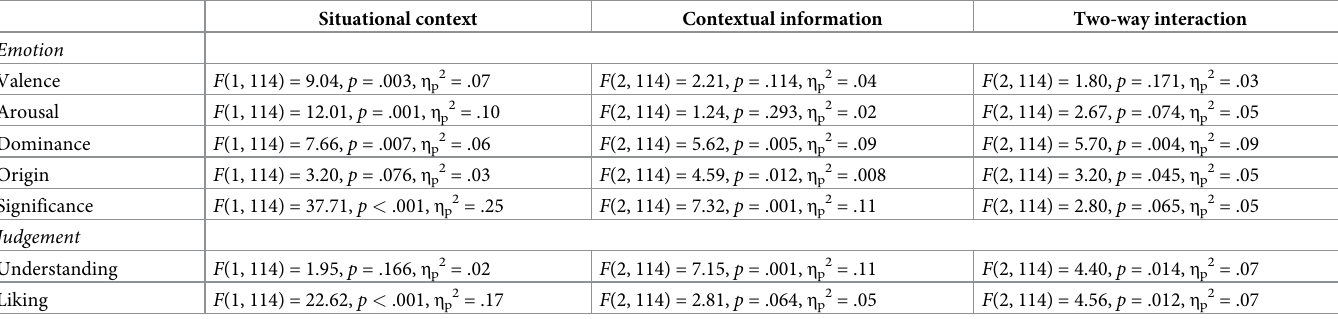
Table 2. Effects of situational context and the way of providing contextual information on aesthetic emotion and aesthetic judgement: Inferential